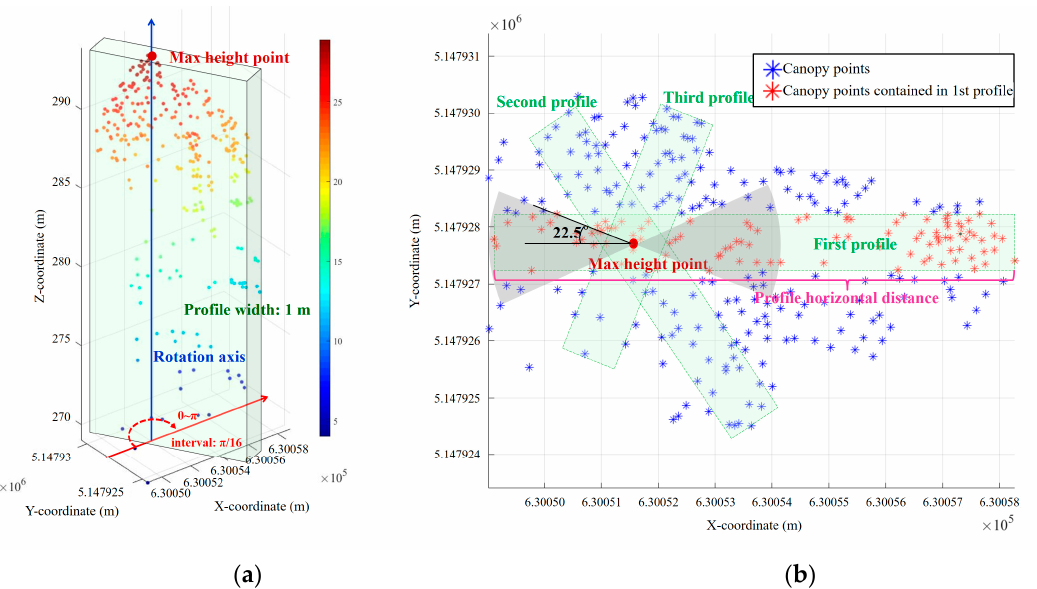
Figure 4. The diagram of three established profiles in a region growing segmentation segment. ( a ) 3D view of the segment, where the vertical profile with a 1 m width was established based on the rotation axis that went through the max height point. ( b ) Top view of the segmentation segment, where the green profile represented the three profiles selected based on the aforesaid rules.